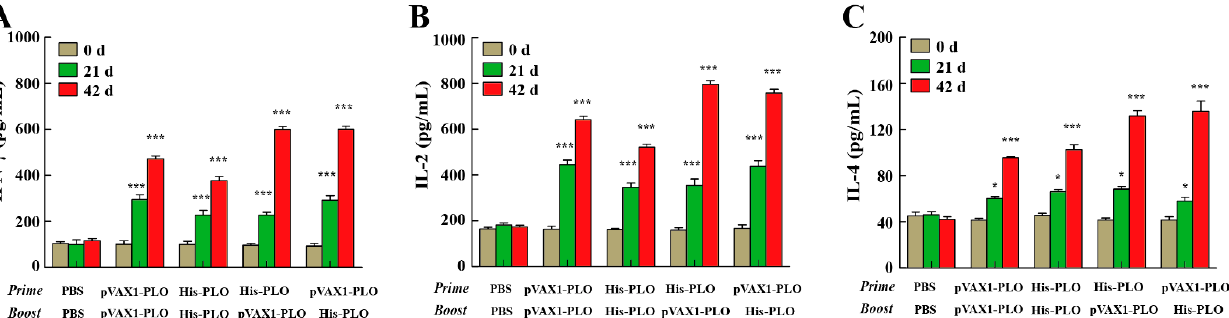
Figure 4. Levels of secreted cytokines from the suspension of the spleen lymphocytes in immunized mice. The spleens were collected at the indicated time points. The levels of IFN- γ ( A ), IL-2 ( B ) and IL-4 ( C ) from the suspension of the spleen lymphocytes were detected by ELISA assays. Data represented means ± SEM of three independent experiments. * p < 0.05, *** p < 0.001.